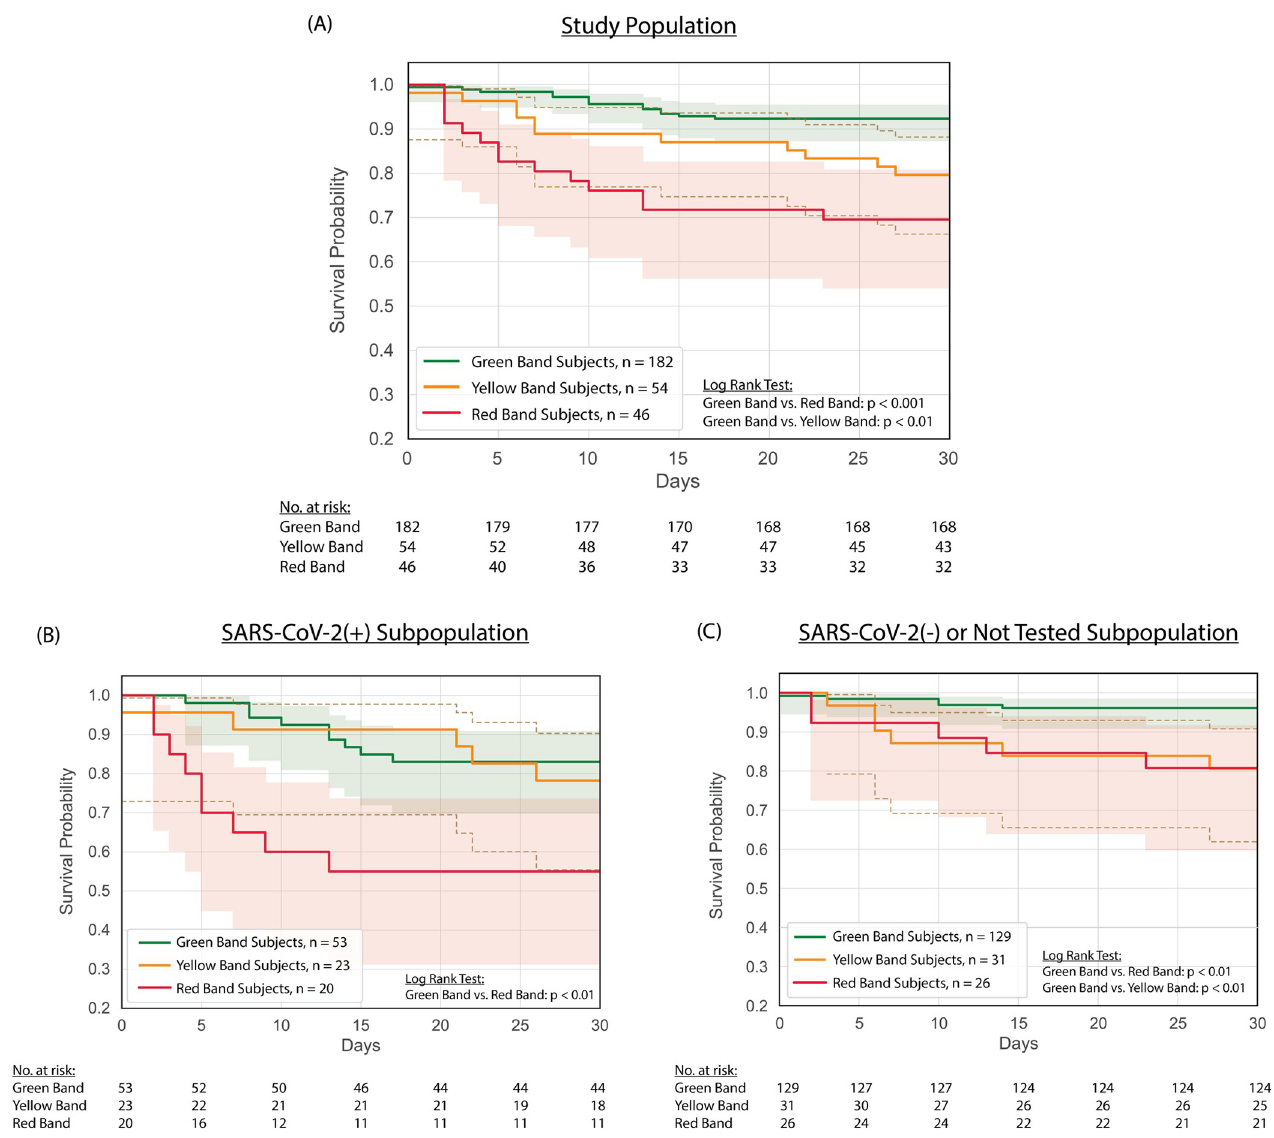
Fig 2. Kaplan-Meier survival stratified by ISI interpretation band for A) all evaluable subjects, B) subjects positive for SARS-CoV-2 infection by nucleic acid amplification test, and C) subjects that were either tested negative or not tested for SARS-CoV-2 infection. Plots were created with right-censoring, with the assumption that subjects discharged from the ED or hospital survived � 30 days in the absence of evidence to the contrary (e.g., return to the ED, discharge to hospice, or other indication in the electronic health record, which was reviewed after 30 days, that the subject died). Shading depicts 95% confidence intervals. At each timepoint, the number at risk, per interpretation band, are noted below the figure